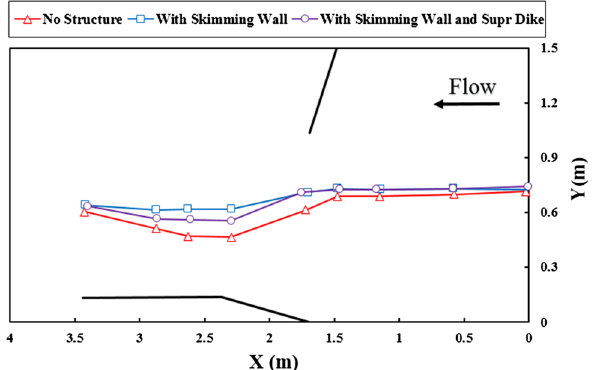
Fig. 13 Change in the location of maximum velocity in the main channel